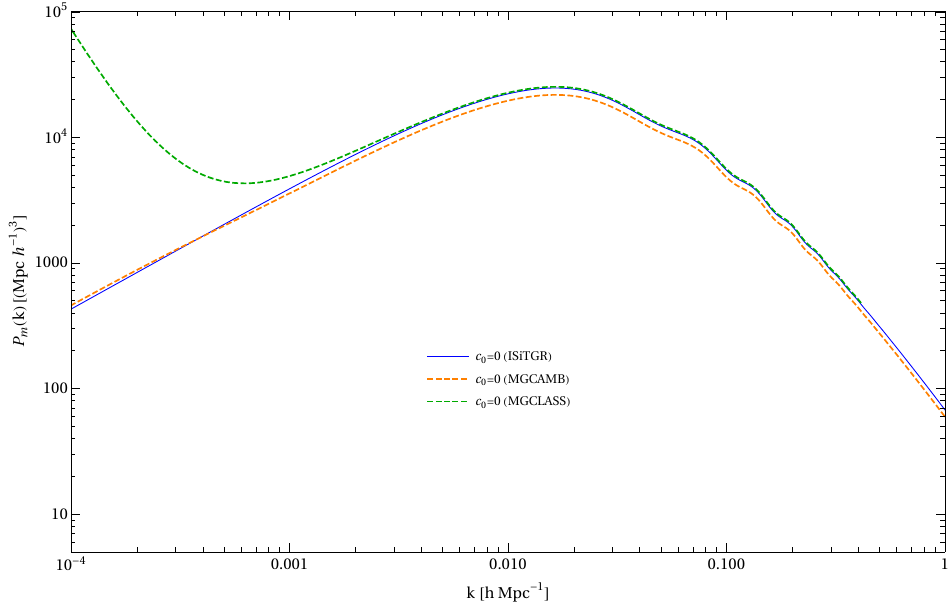
Figure 2. As an example we illustrate the P m ( k ) predictions between the three programs—Integrated Software in Testing General Relativity (ISiTGR) (blue), Modified Growth with CAMB (MGCAMB) (orange) and Modified Growth with CLASS (MGCLASS) (green)—with their corresponding patches for a modified Newton’s constant. This serves as a consistency check between the programs and a validity check for their patches. The solid curves are generated from the respective original Λ CDM programs, while the dashed curves are generated by each program’s modified Newton’s constant patch setting µ ( a , k ) G mod / G Newt = 1. It can be seen that ISiTGR is the most consistent, and hence reliable ≡ program of the three, to investigate the effects of a modified Newton’s